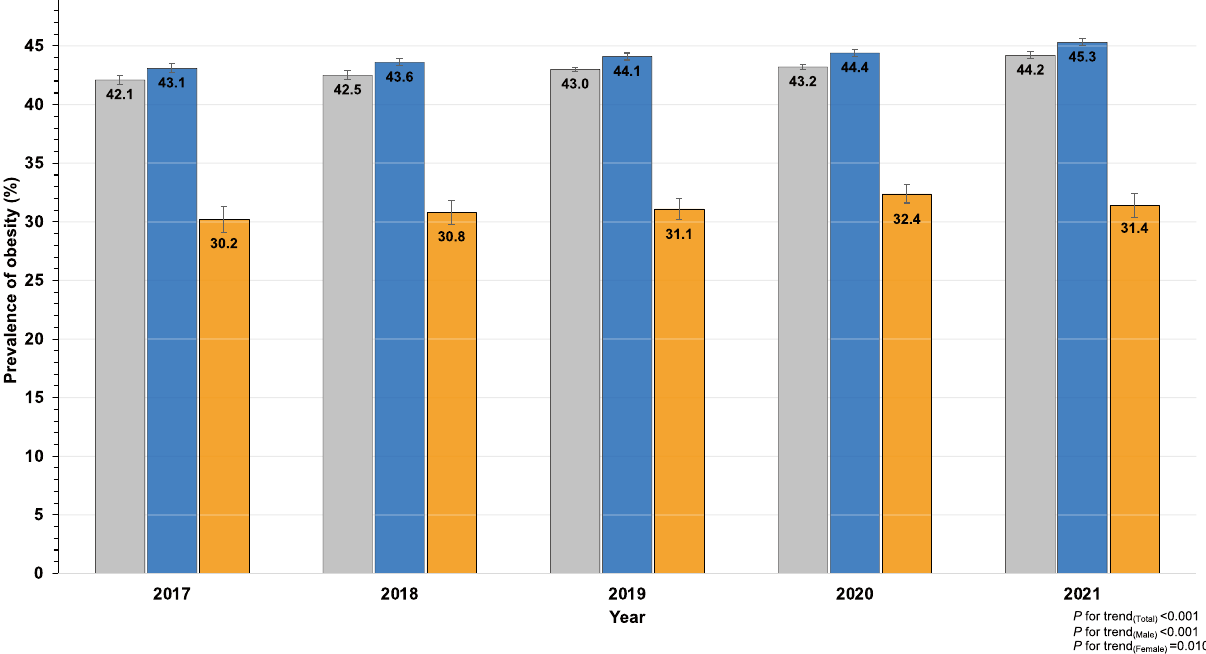
Figure 2. Prevalence of obesity (BMI ≥ 25 kg/m 2 ) and 95% CI among RTA personnel by sex from 2017 to